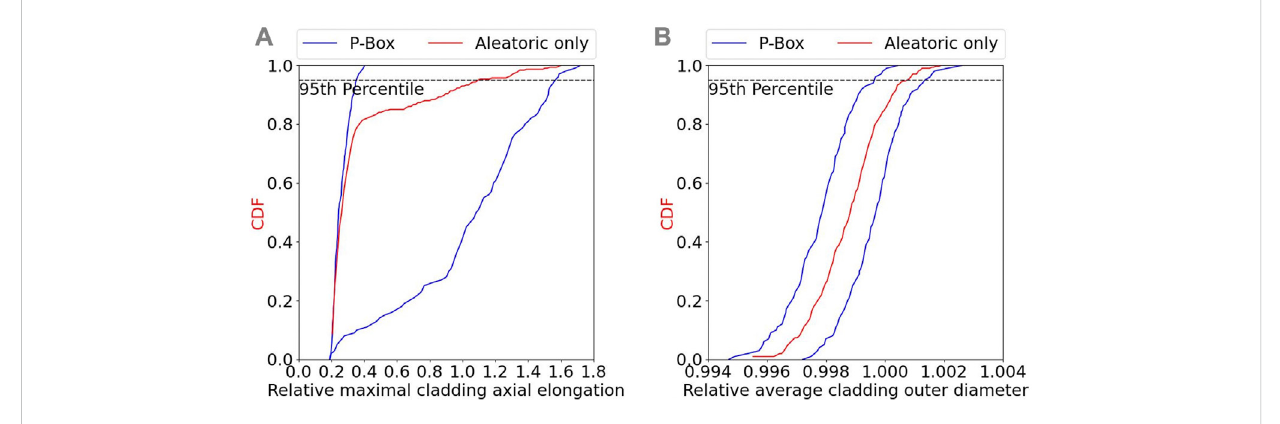
FIGURE 12 UQ results considering all uncertainties as aleatoric for the (A) relative maximal cladding axial elongation and (B) relative average cladding outer diameter. P-boxes obtained previously are also shown for